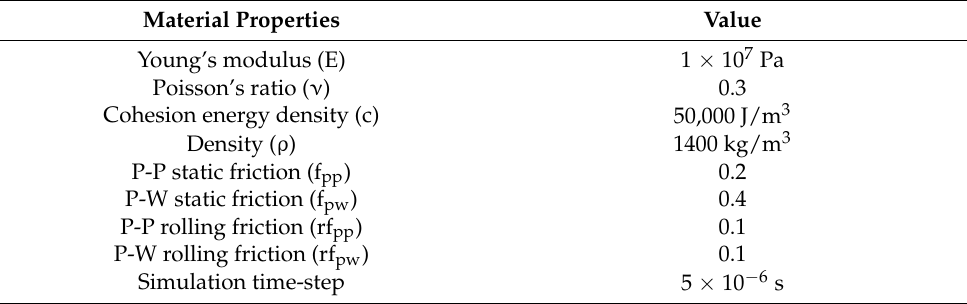
Table 2. Powder material properties and simulation parameters used in the DEM